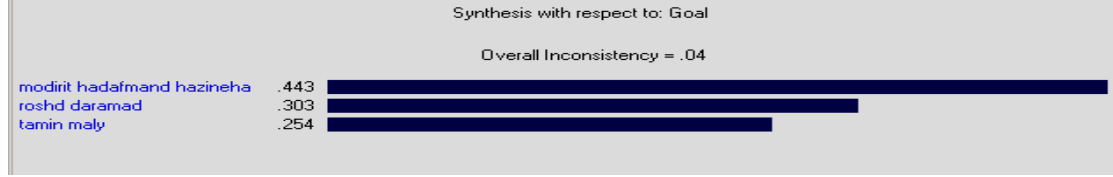
Figure2. Results of the final combination of financial perspective strategies